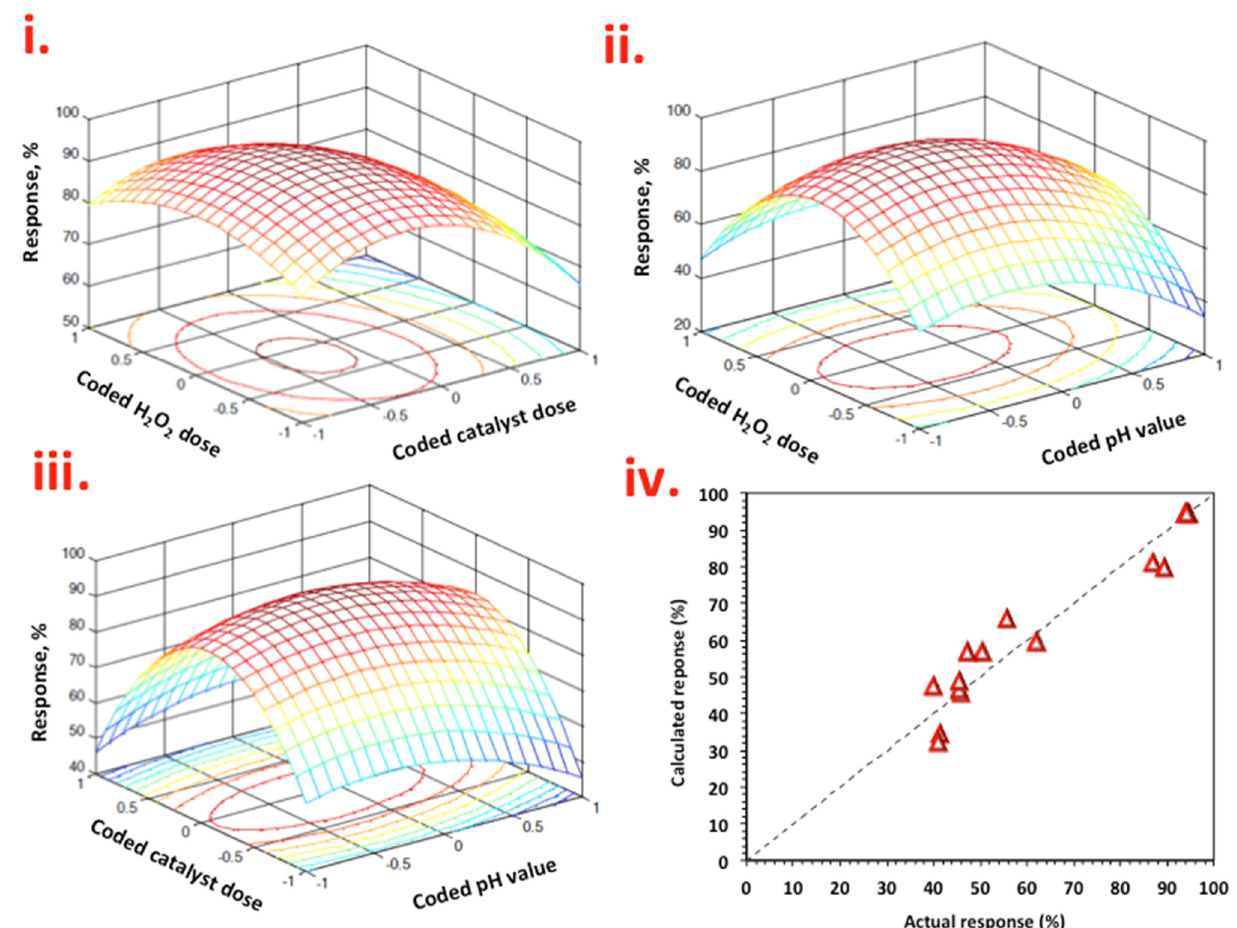
Figure 9. Graphical representation of Box–Behnken response surface design for Nudrin removal as a function of ( i ) 3-D surface and contour plot of coded H 2 O 2 dose and WSD dose, ( ii ) 3-D surface and contour plot of coded H 2 O 2 dose and pH, ( iii ) 3-D surface and contour plot of coded WSD dose and pH and ( iv ) actual and predicated responses.